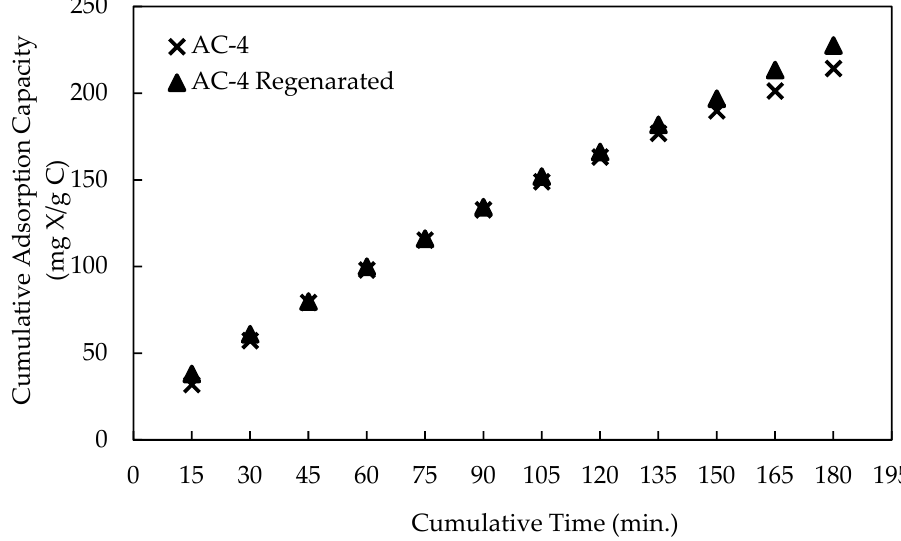
Figure 3. The amount of xanthate adsorbed by fresh and regenerated AC-4; agitation speed, 200 rpm; the volume of xanthate solution, 50 mL; amount of activated carbon, 2 g.